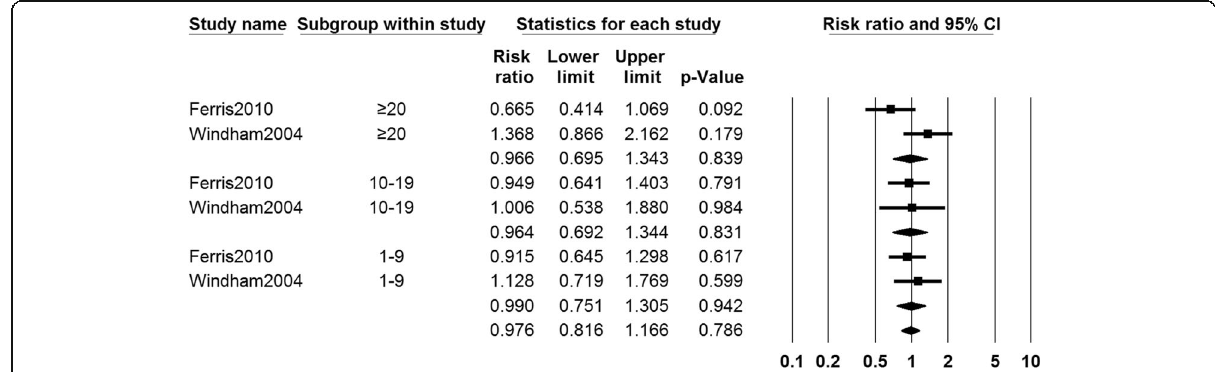
Fig. 6 Forest plot for the number of girls with early menarche between different PTS exposure levels group and control group